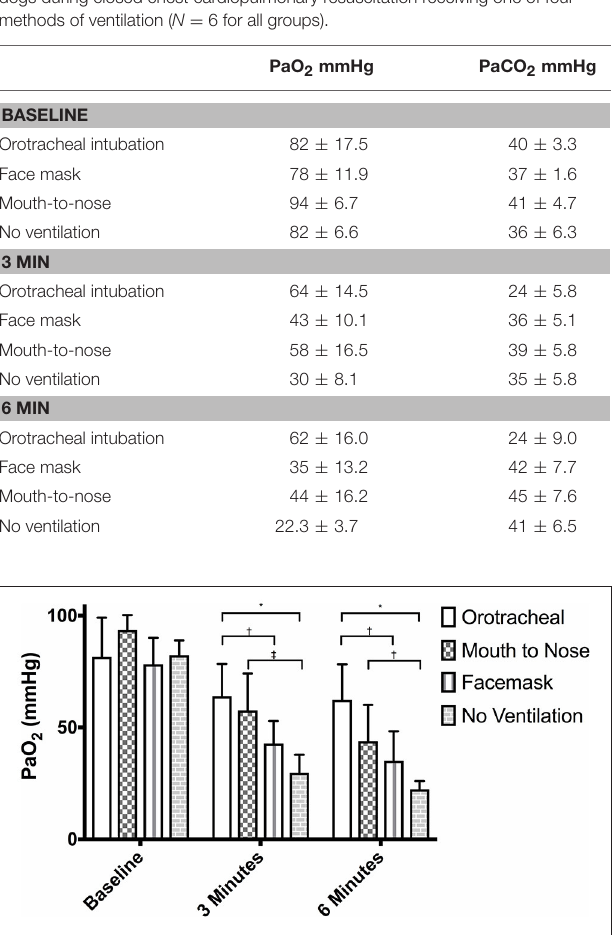
FIGURE 1 | Mean PaO 2 of dogs at baseline and at 3 and 6min of cardiopulmonary resuscitation when ventilated via one of four techniques without supplemental oxygen. Bars represent standard deviation. * P < 0.001, † P < 0.05, ‡ P < 0.01. Orotracheal, ventilation with bag resuscitator and cuffed orotracheal tube; Mouth-to-nose, rescue breaths with mouth over the nose; face mask, ventilation with bag resuscitator and a tight fitting face mask; No ventilation, compression only